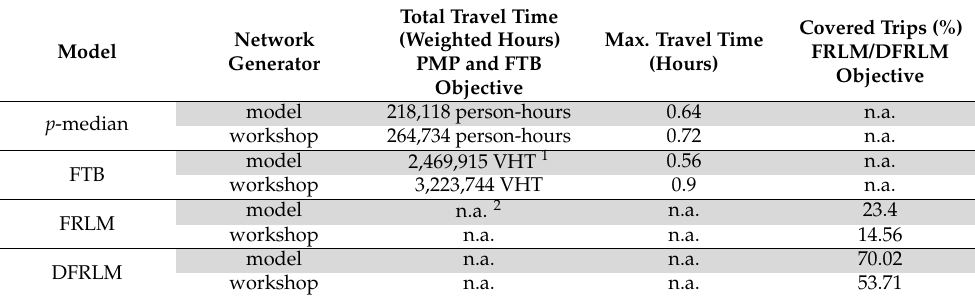
Table 9. Comparison of model and workshop coverage results for 8